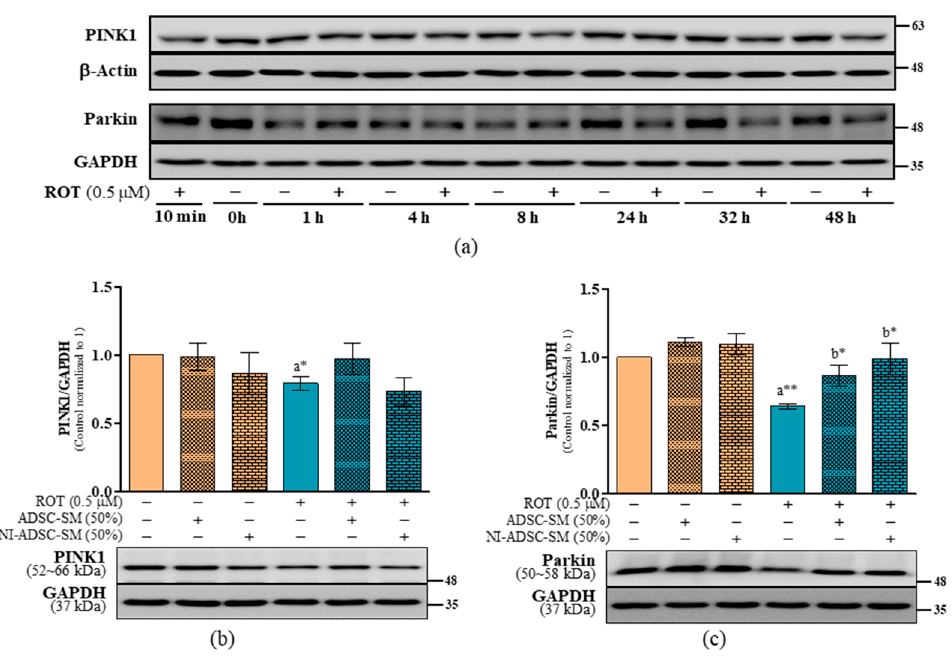
Figure 3. Effects of the NI-ADSC-SM on mitophagy-related proteins. Cells treated with or without ROT (0.5 µ M) at different timepoints were assessed for PINK1 and parkin by Western blotting ( a ). Cells were incubated in the presence of ROT (0.5 µ M) or DMSO for 48 h and then treated with the ADSC-SM or NI-ADSC-SM (each diluted by 50%) during the last 24 h. The levels of PINK1/GAPDH ( b ) and parkin/GAPDH ( c ) protein expression were assessed by Western blotting. Data are shown as the mean (bars) and SEM (error bars) of three independent cell culture experiments. Statistical